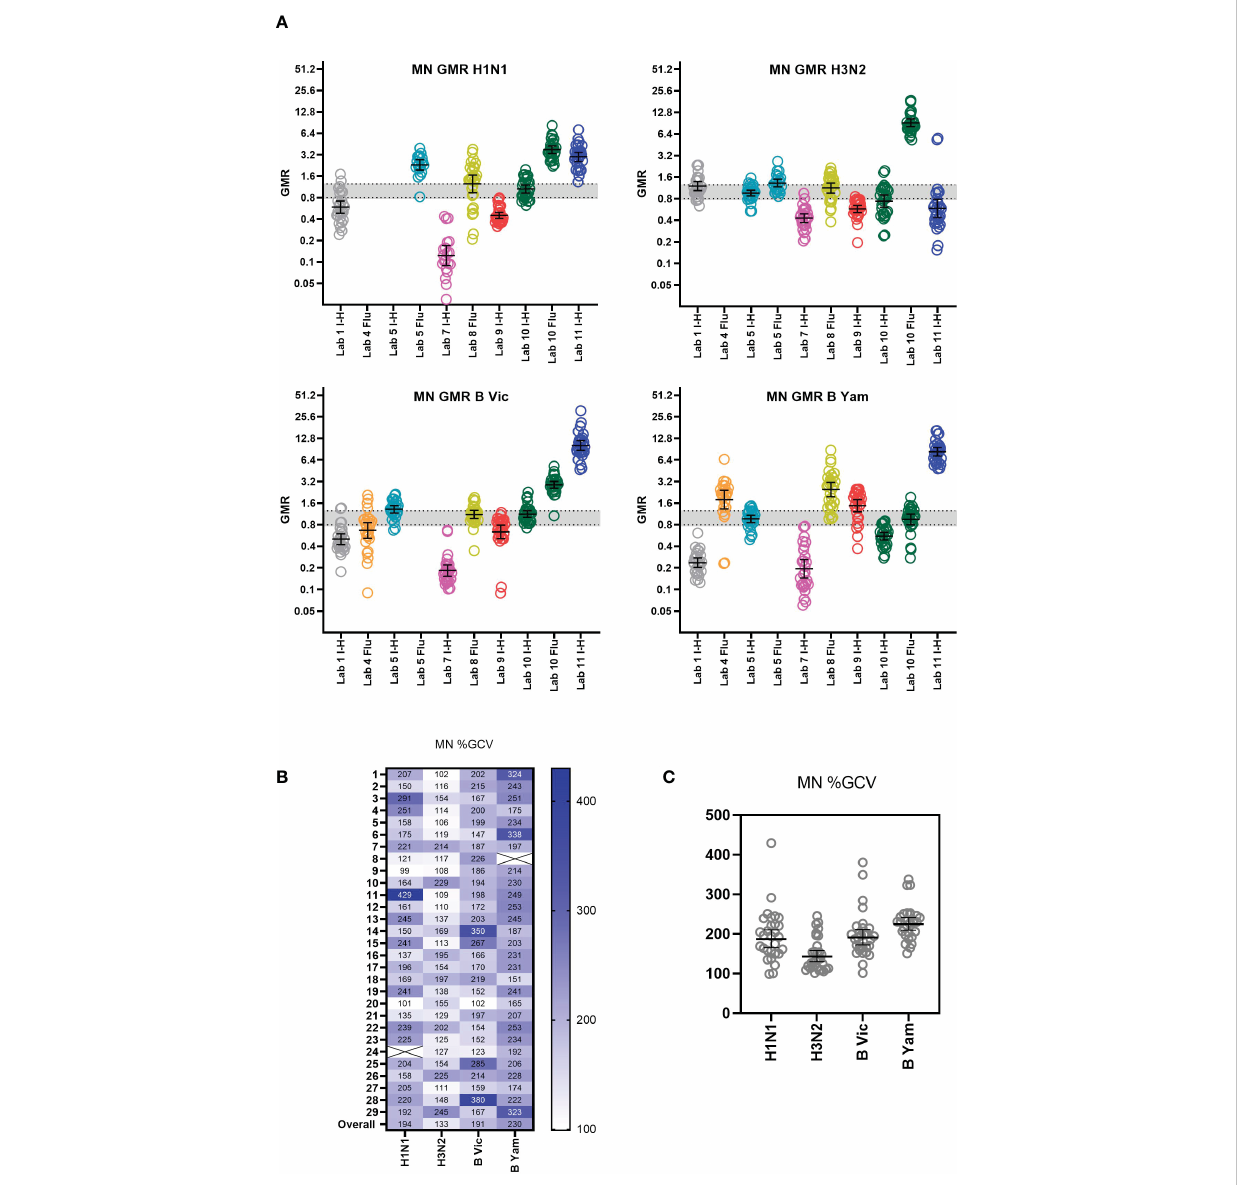
FIGURE 6 Inter-laboratory variation in MN testing. (A) GMR of each sample MN titre compared to the global GMT of that sample across all testing laboratories. Geometric mean of GMRs and 95% CI are shown in black. Laboratories are colour coded and labelled along with protocol type on the x axis. The indicative interval of 0.8-1.25 is shaded in grey. Each laboratory has a unique number and colour in all graphical representation of data. (B) %GCV of each sample MN titre across the testing laboratories. Samples with a GMT <10 were excluded from analysis (shown as Xs in the fi gure). (C) %GCV of each sample MN titre plotted by subtype and lineage. Geometric mean of %GCV and 95% CI are shown in as black